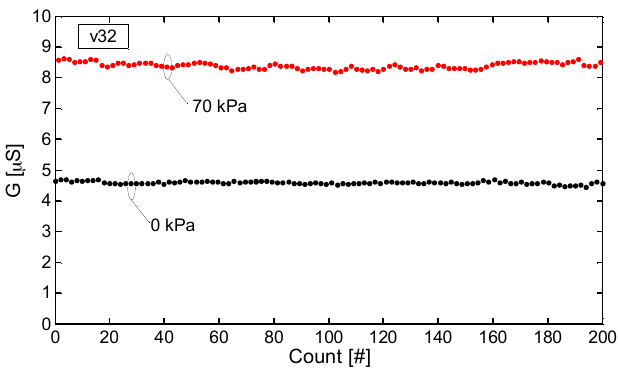
Figure 16. Conductance measured at the beginning (0 kPa) and at the end (70 kPa) of one hundred consecutive monotonic loading tests carried out at the crosshead speed v 32 .